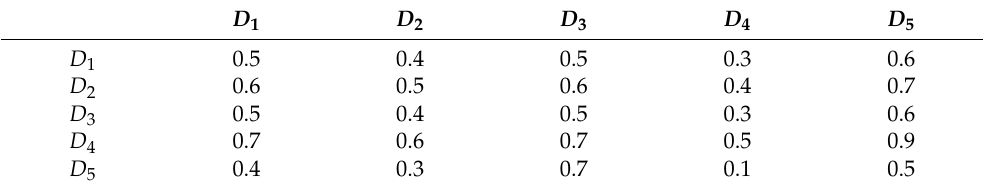
Table 5. Pairwise comparison results of subject attribute